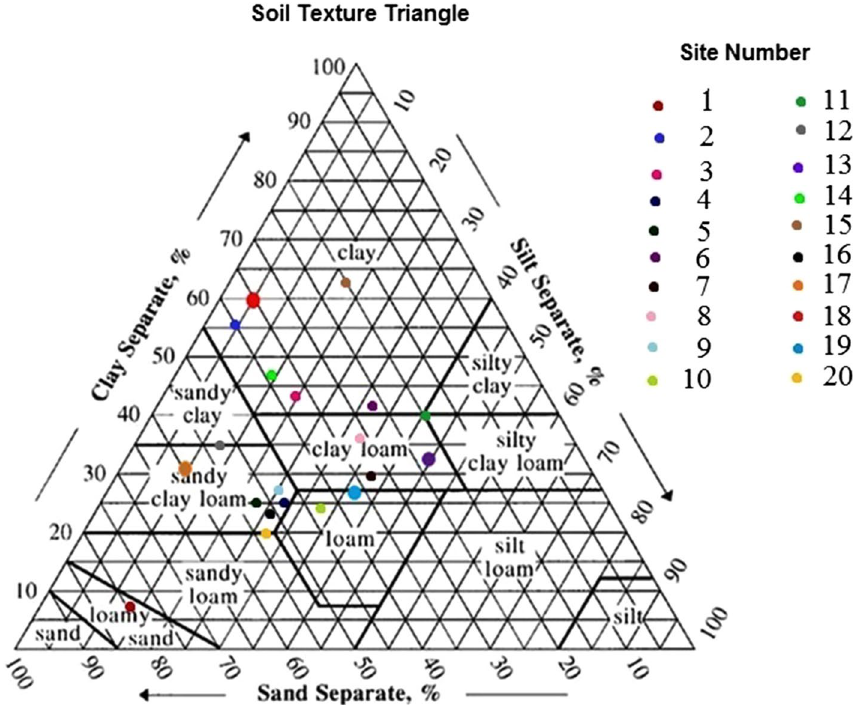
Fig. 2 Texture of the soil for the study